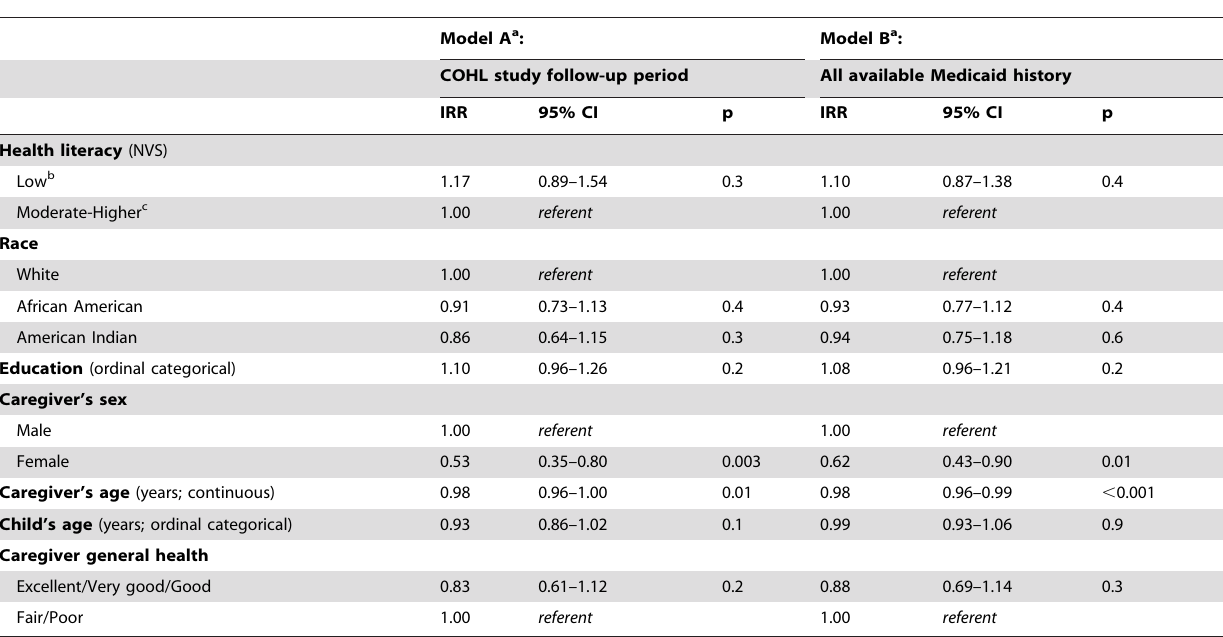
Table 3. Results of Multivariate Poisson Regression Modeling of Medicaid Enrollment Gap Incidence on Caregiver and Child Characteristics, among the COHL Study Follow-up Cohort in North Carolina, during the Study Period (A) and Using all Available Medicaid History (B) between January 2004 and December 2010.